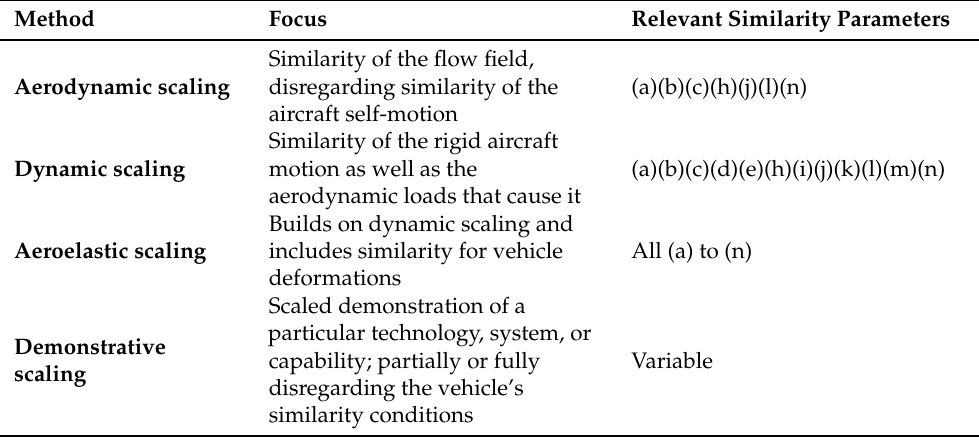
Table 2. The most common scaling methods used in SFT experiments can be grouped into four different